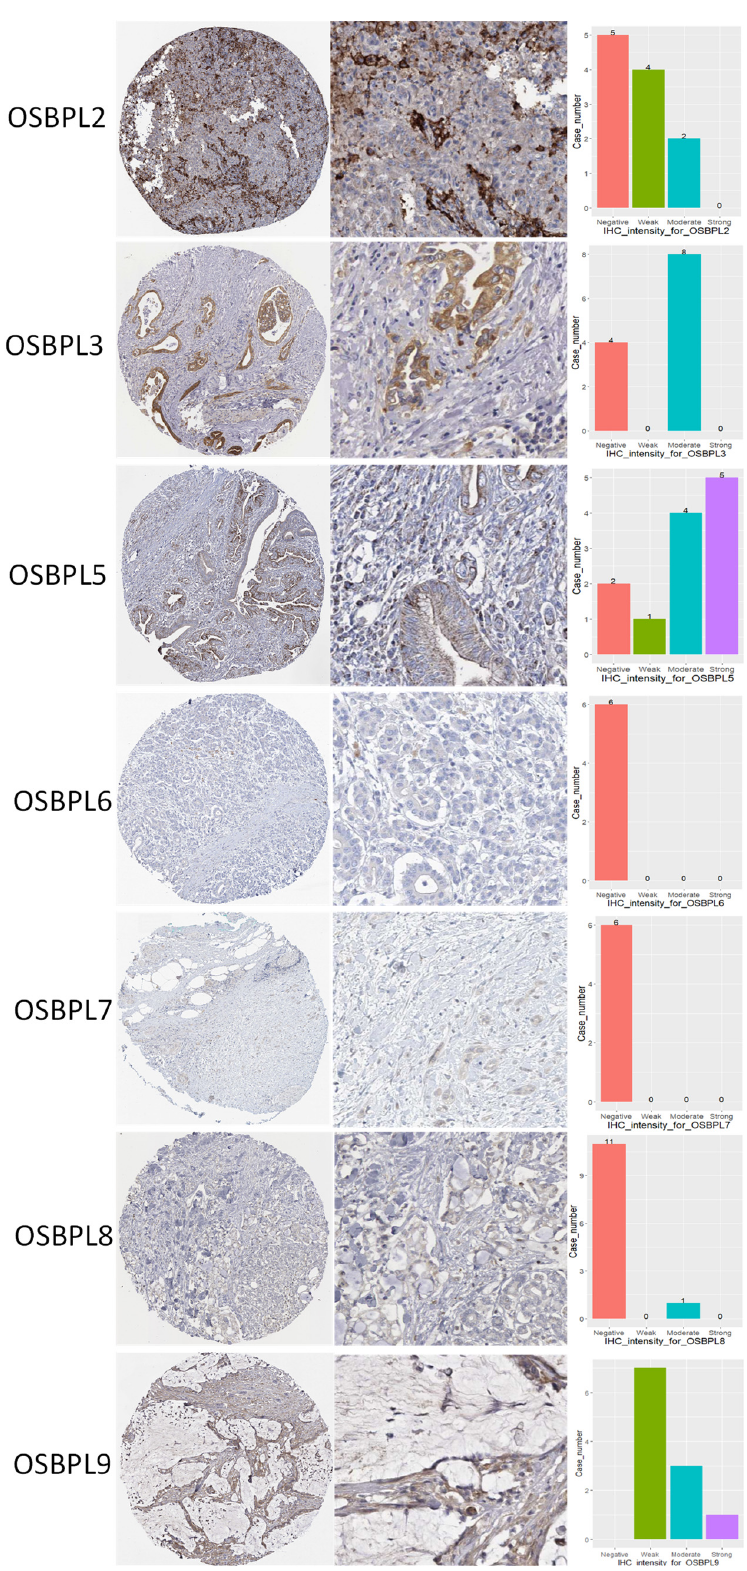
Figure 5. Protein expression levels of oxysterol-binding protein (OSBP)-like (OSBPL) family members in clinical pancreatic ductal adenocarcinoma (PDAC) tissues. Protein expression data of OSBPL family members in cancer specimens were acquired from the Human Protein Atlas. Bar charts show the IHC staining intensities of OSBPL family proteins from the PDAC dictionary.